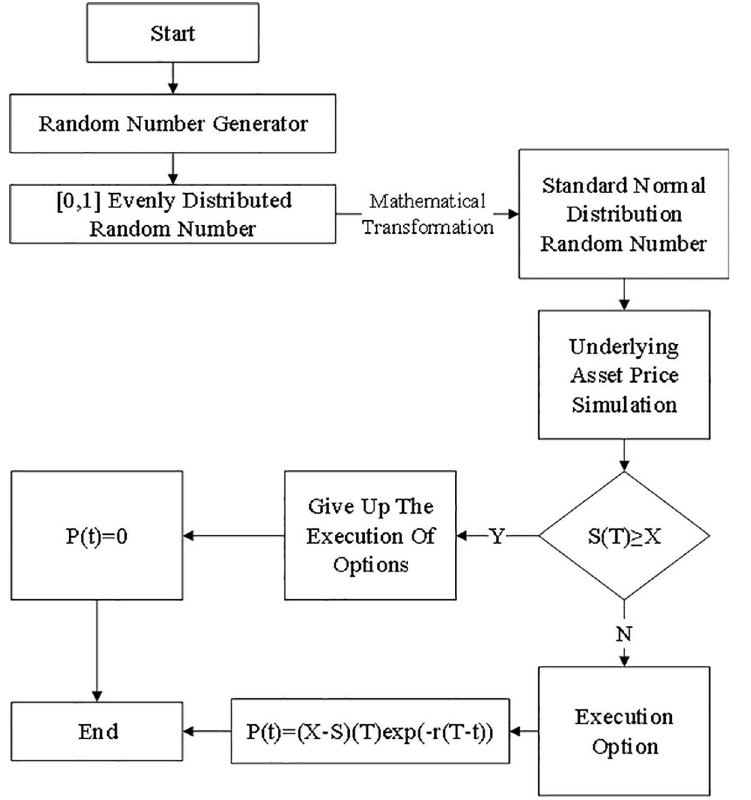
Fig 3. Monte Carlo simulation flow of European options.